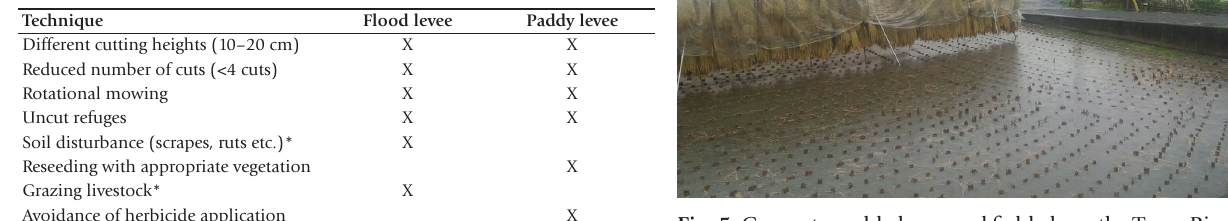
Table 3. Sward management techniques for conserving popula- tions of Orthoptera on flood defense and paddy levees in Japan (X indicates a suitable measure).